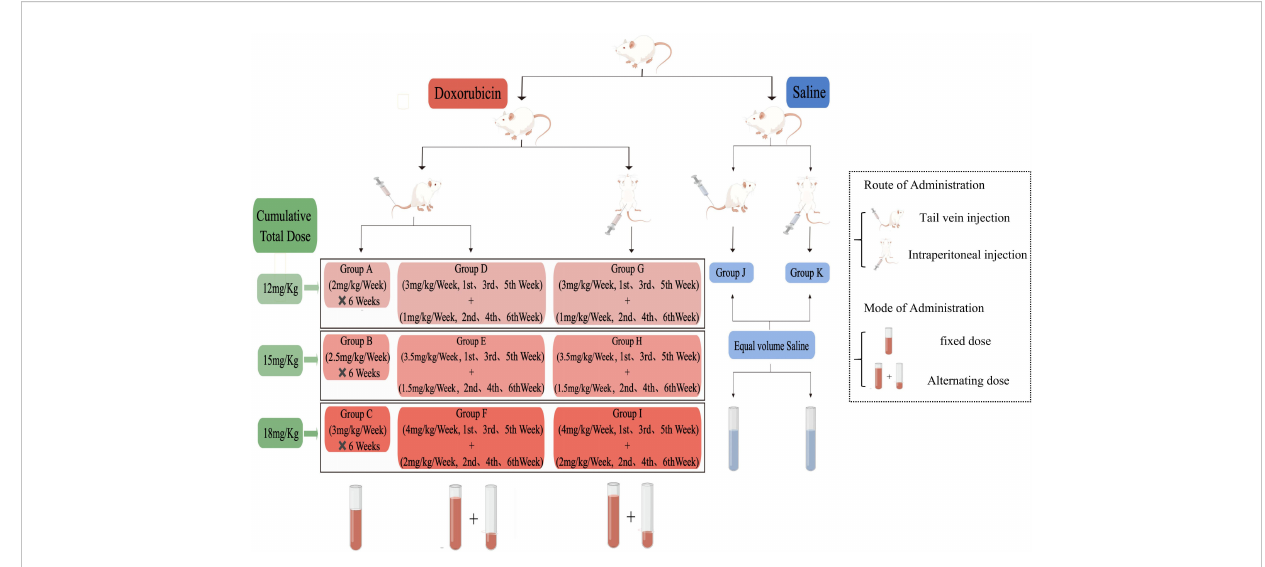
FIGURE 1 Schematic diagram of the study